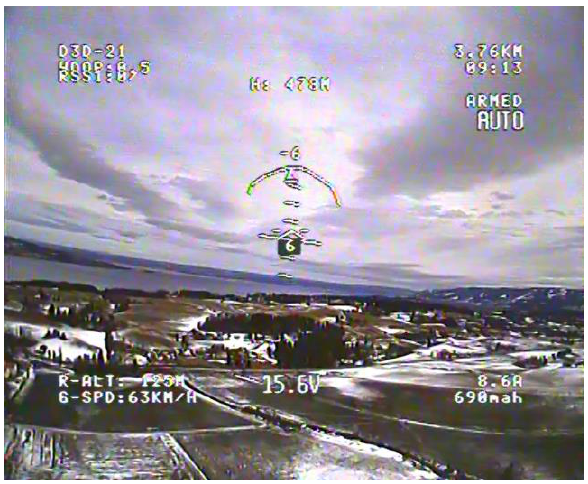
Figure 3. Screenshot of the live video feed of the front camera with overlaid flight data during an autonomous flight over the test